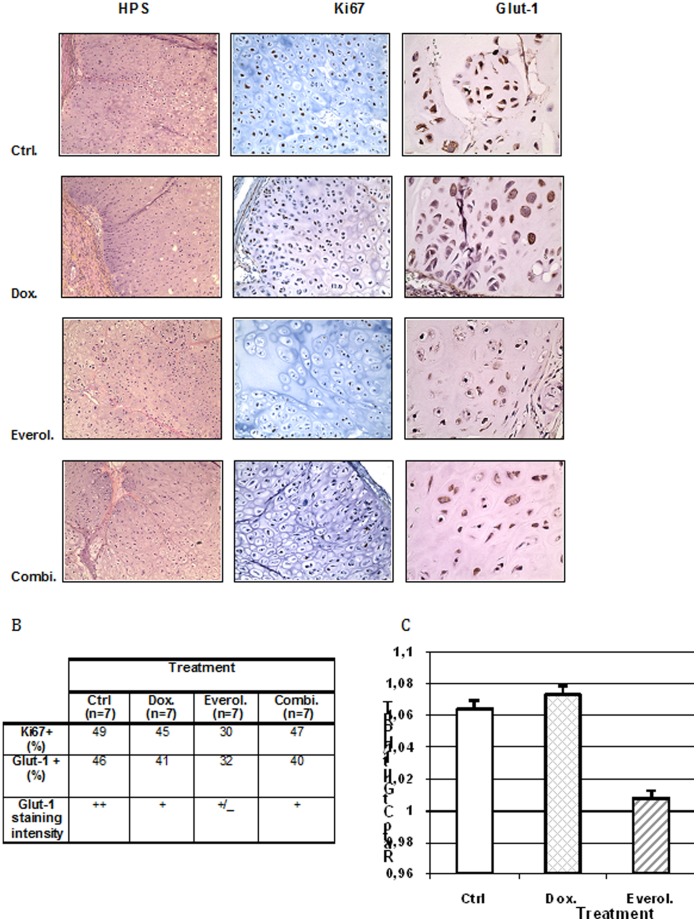
Everolimus inhibits tumor cell proliferation and glucose metabolism.A, Tumor cell proliferative rate (Ki67+ cells) and glucose metabolism were significantly decreased after everolimus treatment. Tumors were harvested, fixed and stained by HPS, anti-Ki67 or anti-Glut-1 antibody to respectively show tumor proliferative fraction and glucose metabolism. B : Summary of Ki67 and Glut-1 expression for each treatment group.Ctrl: control group, Dox: doxorubicin-treated group; Everol: everolimus-treated group; combi: everolimus + doxorubicin combination-treated group. C: histogram showing Glut-1 mRNA expression after each treatment. Glut-1 mRNA induction was unchanged in response to doxorubicin and decreased after everolimus treatment.